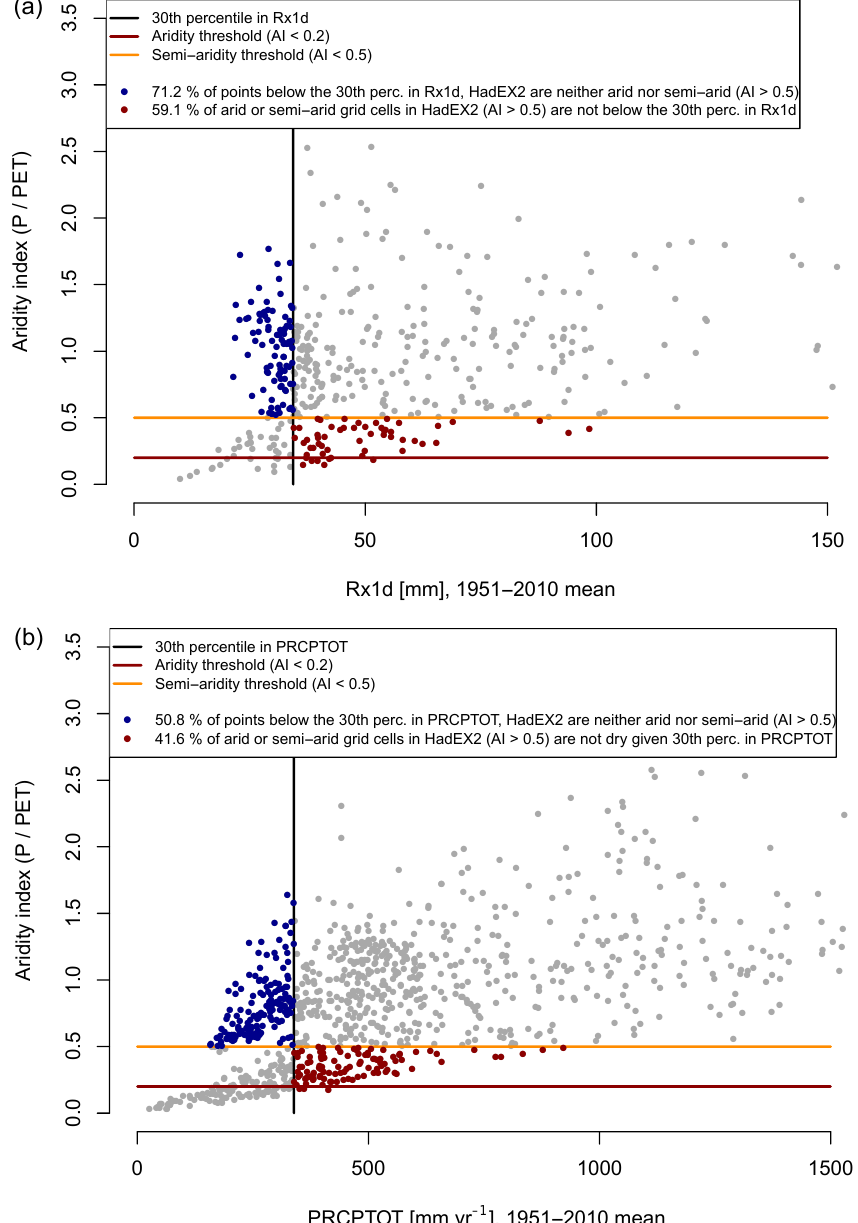
Figure B1. Relationship between annual-maximum daily rainfall (Rx1d from HadEX2–GHCNDEX-merged dataset) and aridity (a) , and precipitation totals (PRCPTOT from HadEX2–GHCNDEX-merged dataset) and aridity (b) . Potential evapotranspiration is taken from the CRU-TS3.23 dataset (Harris et al.,